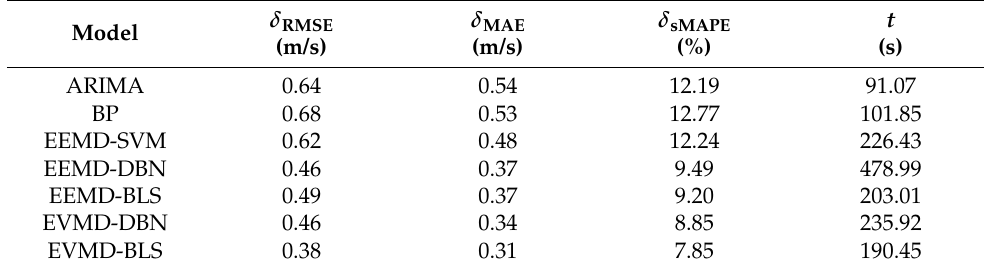
Table 2. Evaluation result of seven forecasting models.